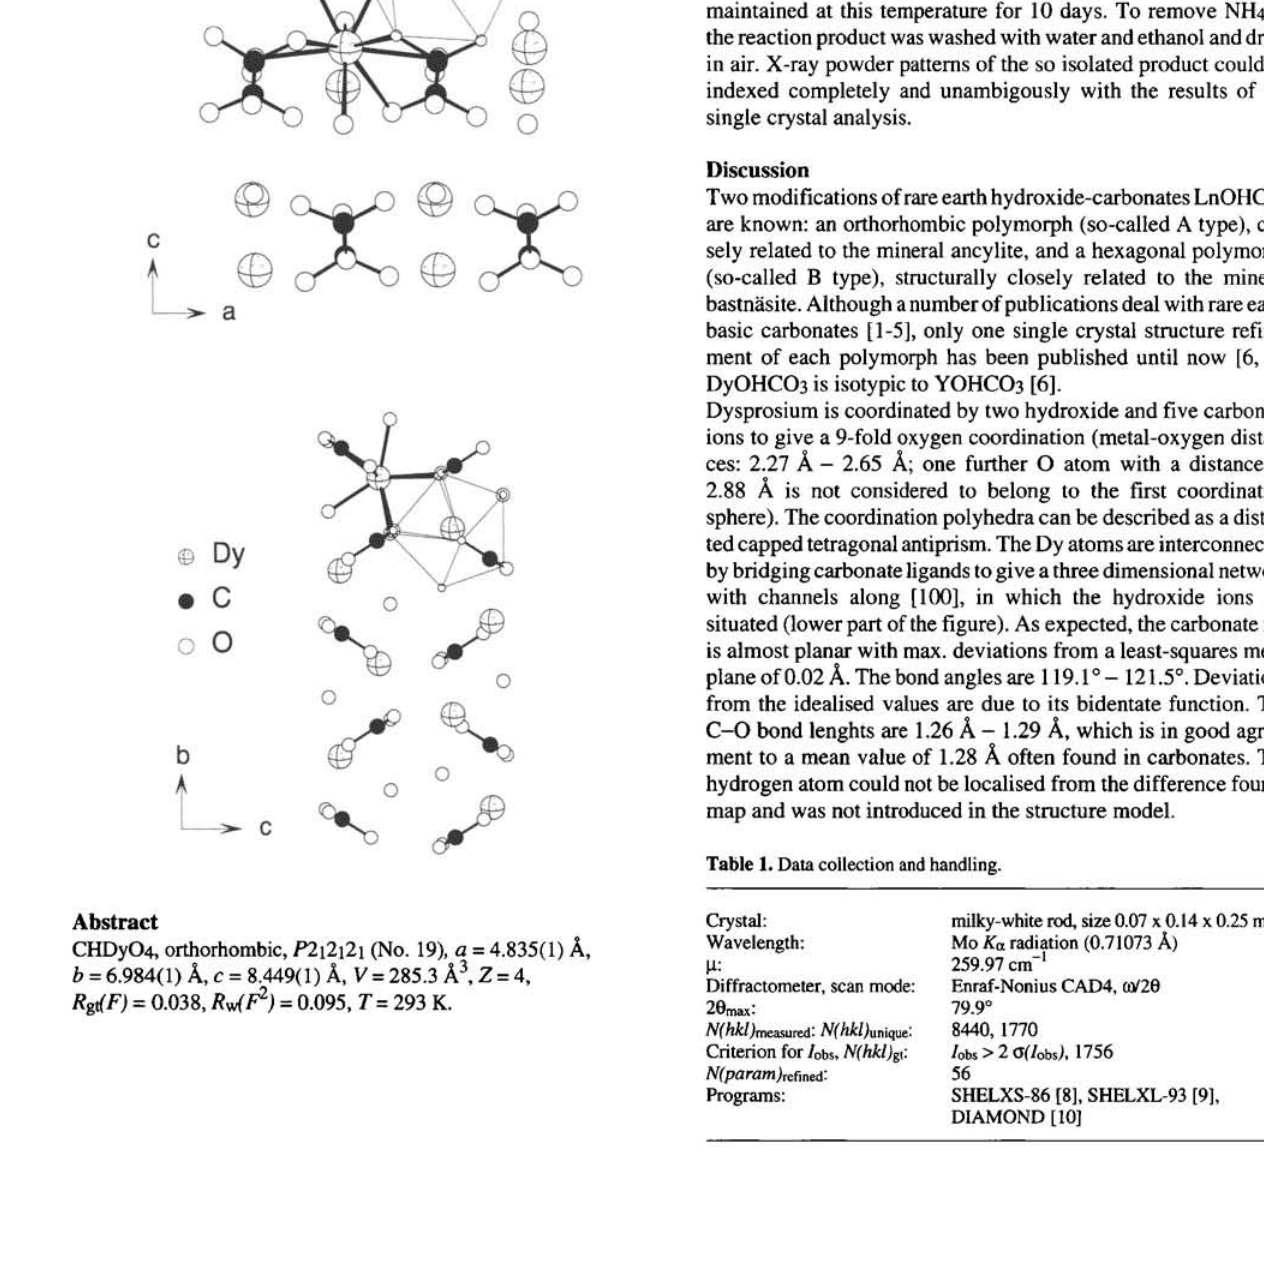
Table 1. Data collection and